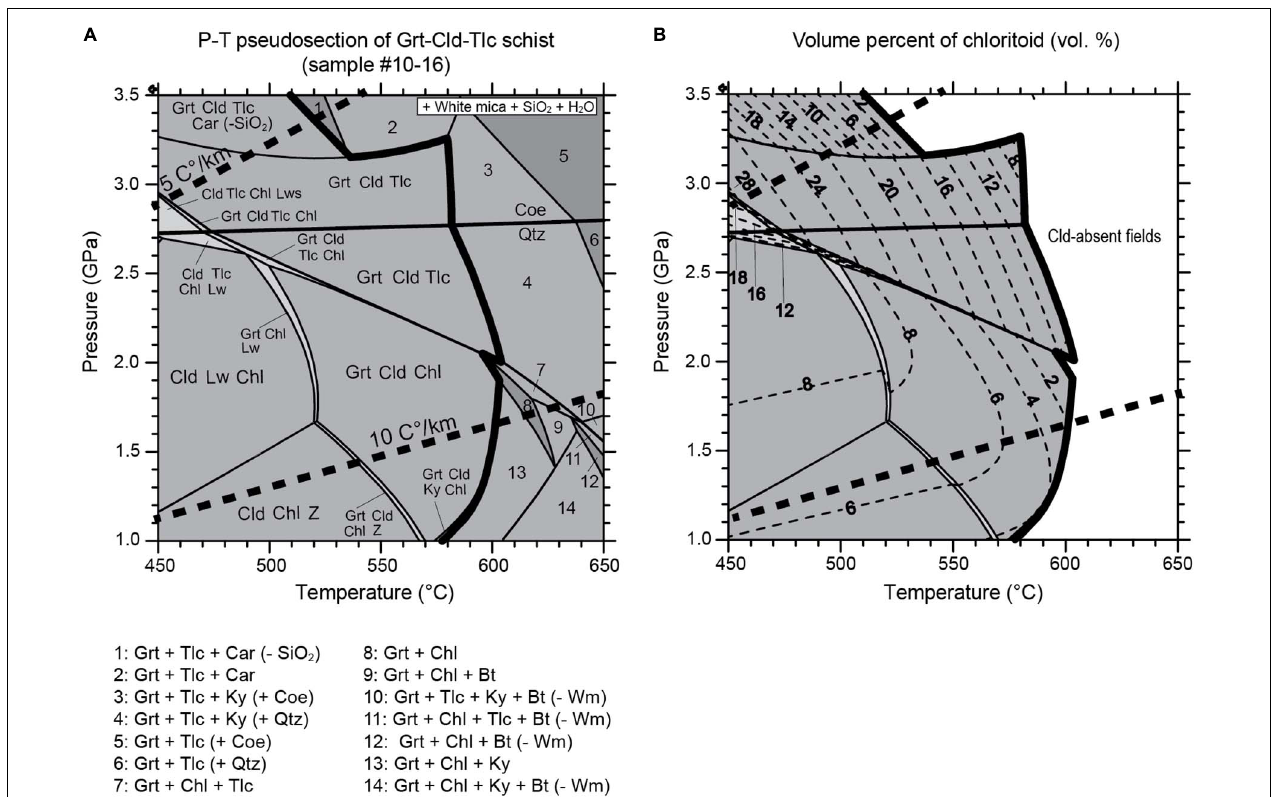
FIGURE 6 | P–T pseudosection showing the chloritoid-stability fields and the volume percentage isopleths of chloritoid. (A) P–T pseudosection calculated for the Grt-Cld-Tlc schist (sample #10–16) in the model system CKFMASH. Bulk composition in mol%: SiO 2 , 49.0; Al 2 O 3 , 11.0; FeO, 17.0; MgO, 22.5; CaO, 0.2; K 2 O, 0.2; H 2 O is excess. Dashed bold lines denote the geothermal gradients of 5 and 10 ◦ C/km, respectively. Chloritoid-out curve is indicated by solid bold line. Mineral abbreviation: Grt, garnet; Cld, chloritoid; Tlc, talc; Chl, chlorite; Wm, white mica; Bt, biotite; Lw, lawsonite; Ky, kyanite; Car, carpholite; Z, zoisite. (B) Volume percentage isopleths of chloritoid. The geothermal gradients are the same as in (A)